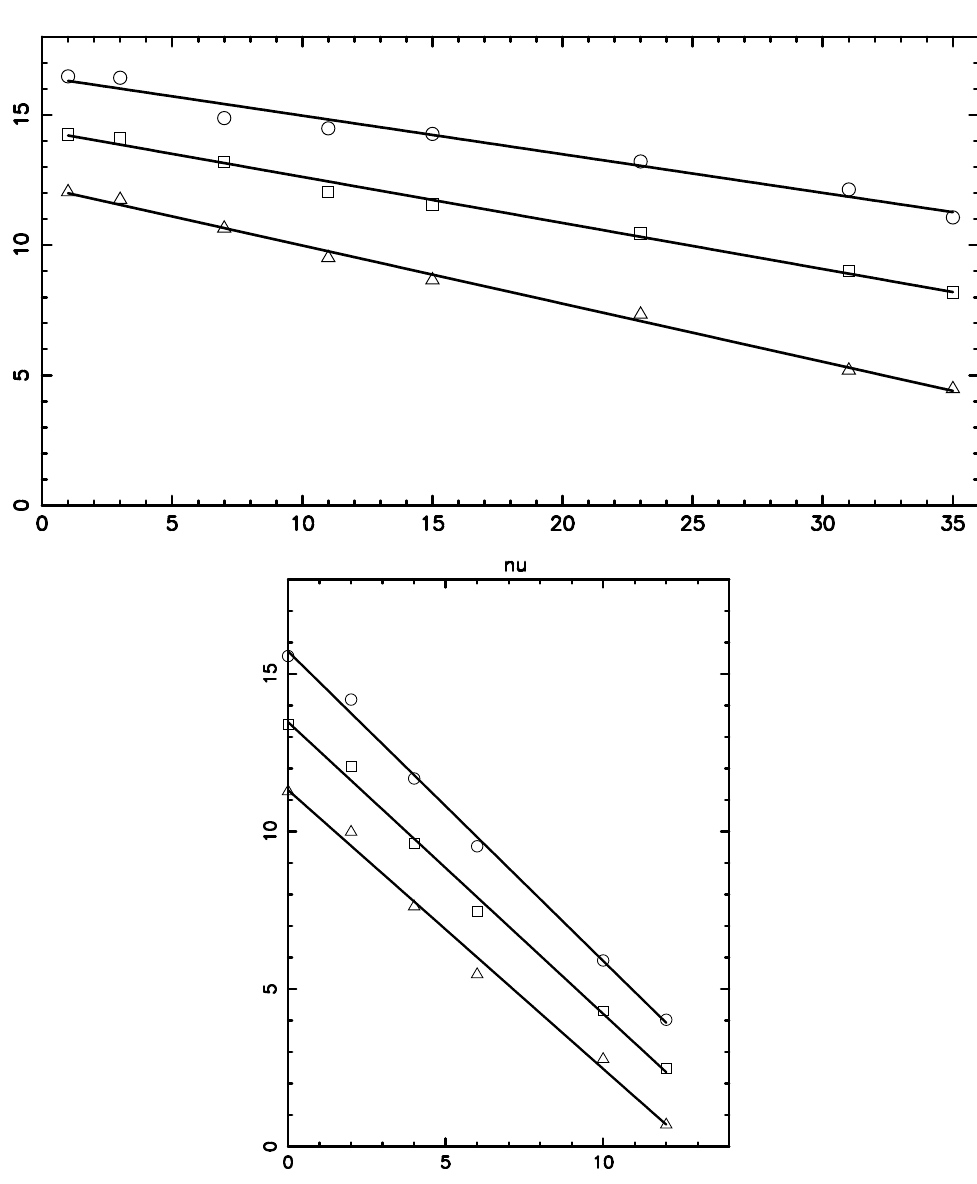
Figure 6: Top: initial branch of cods at ν = 1 , 3 , 7 , 11 , 15 , 23 , 31 , 35 . Bottom: initial branch of ravens at ν = 0 , 2 , 4 , 6 , 10 , 12 . Triangle: n = 5 10 5 ; square: n = 5 10 6 ; circle: n = 5 10 7 . Continuous line: linear